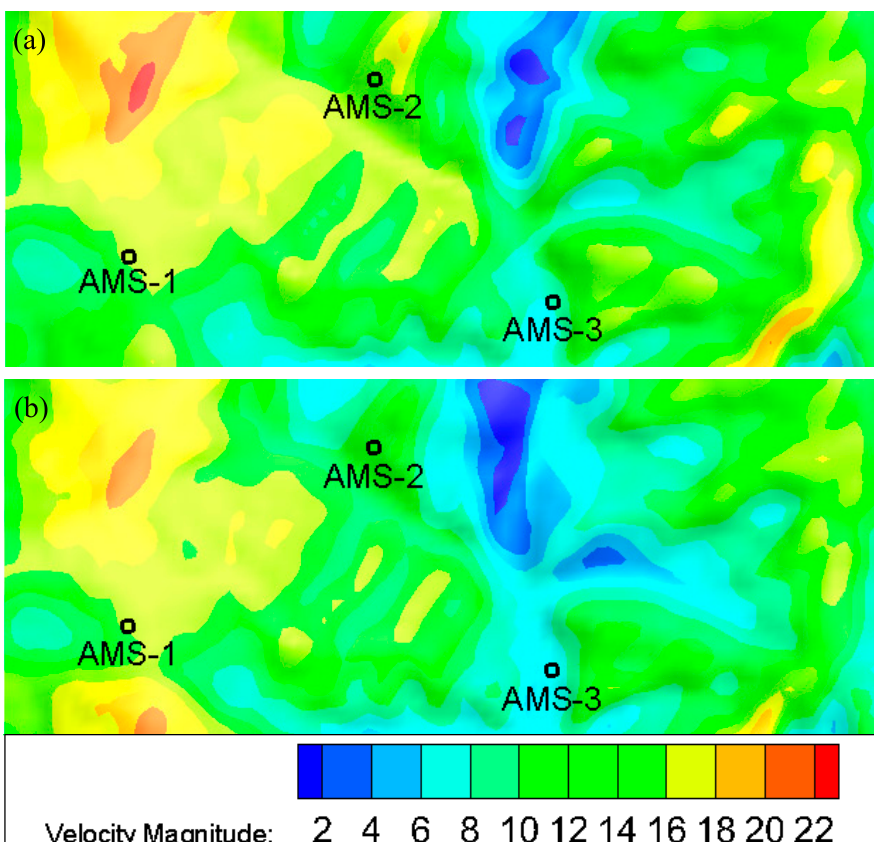
Figure 8. Partial distribution of wind velocity (m / s) near ground simulated by the CFD-1 ( a ) and CFD-2 ( b ) models, on 22 May 2018 at 16:00 UTC.